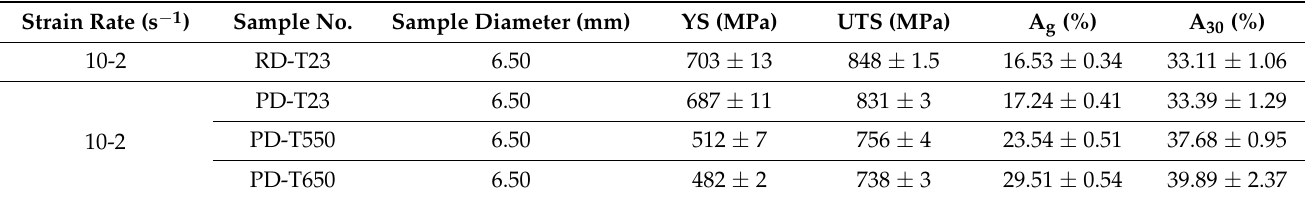
Table 2. Tensile test results for the basic material both in the rolling direction (RD) and in the direction perpendicular to the rolling direction (PD). Strain Rate (s − 1 ) Sample